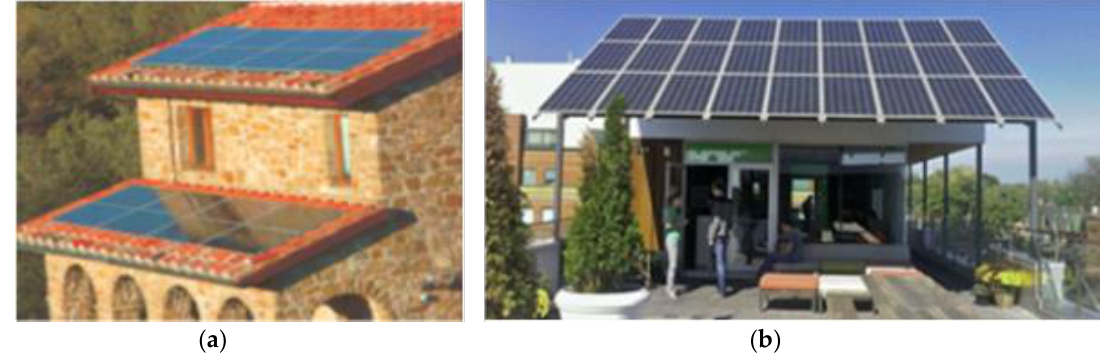
Figure 1. Some examples of building-integrated photovoltaic (BIPV) systems on buildings: ( a ) country house; ( b ) modern building.